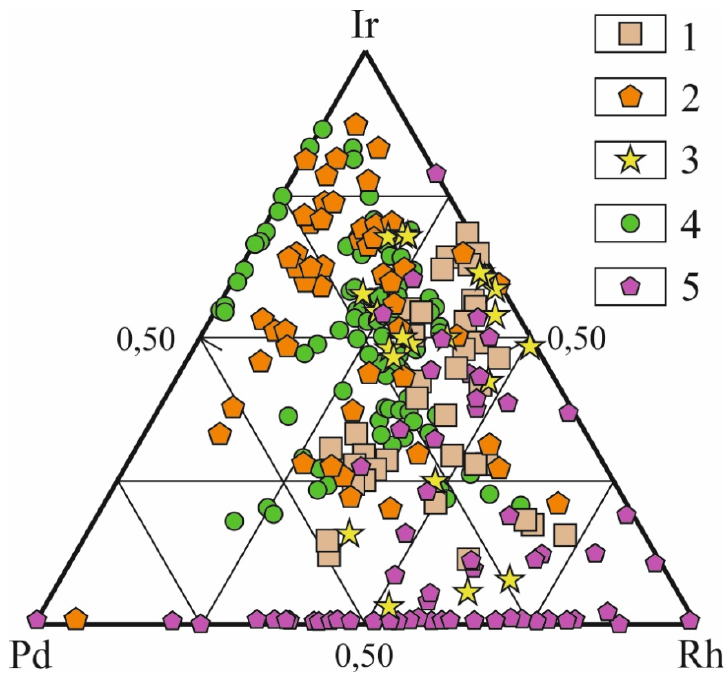
Figure 16. The concentrations of minor elements in isoferroplatinum from lode chromite-platinum mineralization (1), the Vershinniy eluvial placer (2), the Travyanistyi proximal placer (3), the Glubokinskoe distal placer (4), the lode and placer mineralization of the Veresovoborsky massif